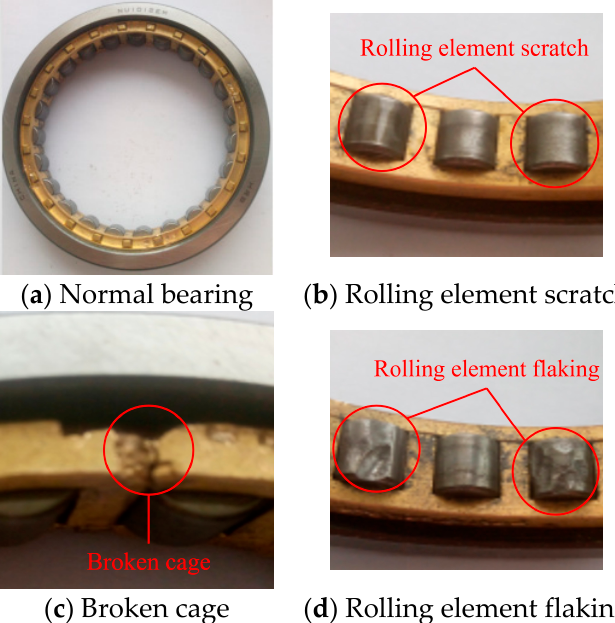
Figure 9. Four kinds of test bearing.